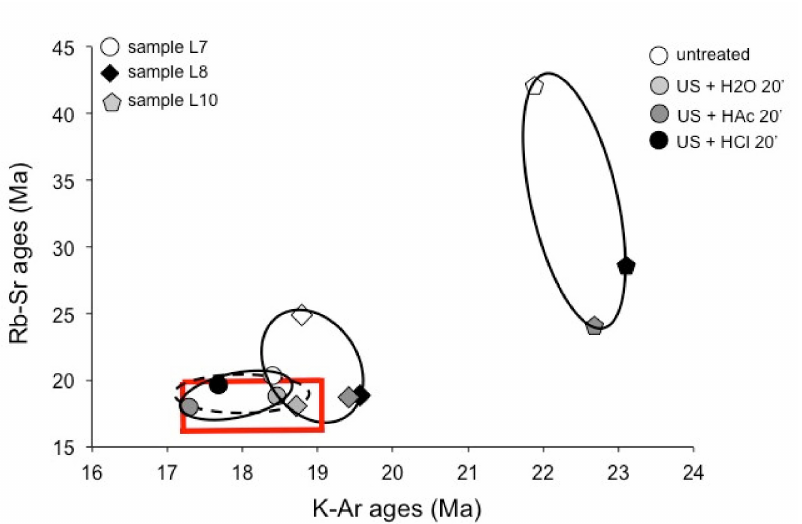
Figure 5. Synoptic chart of the Rb–Sr and K–Ar isotopic results of all L7, L8 and L10 glauconite aliquots. The red rectangle locates the stratigraphic age of the samples, each branch giving the analytical uncertainty for each method. The three full-lined circles integrate the data points of each sample, while the dashed-line circles identify the five data points within the stratigraphic age. The colored symbols to the right stand for all